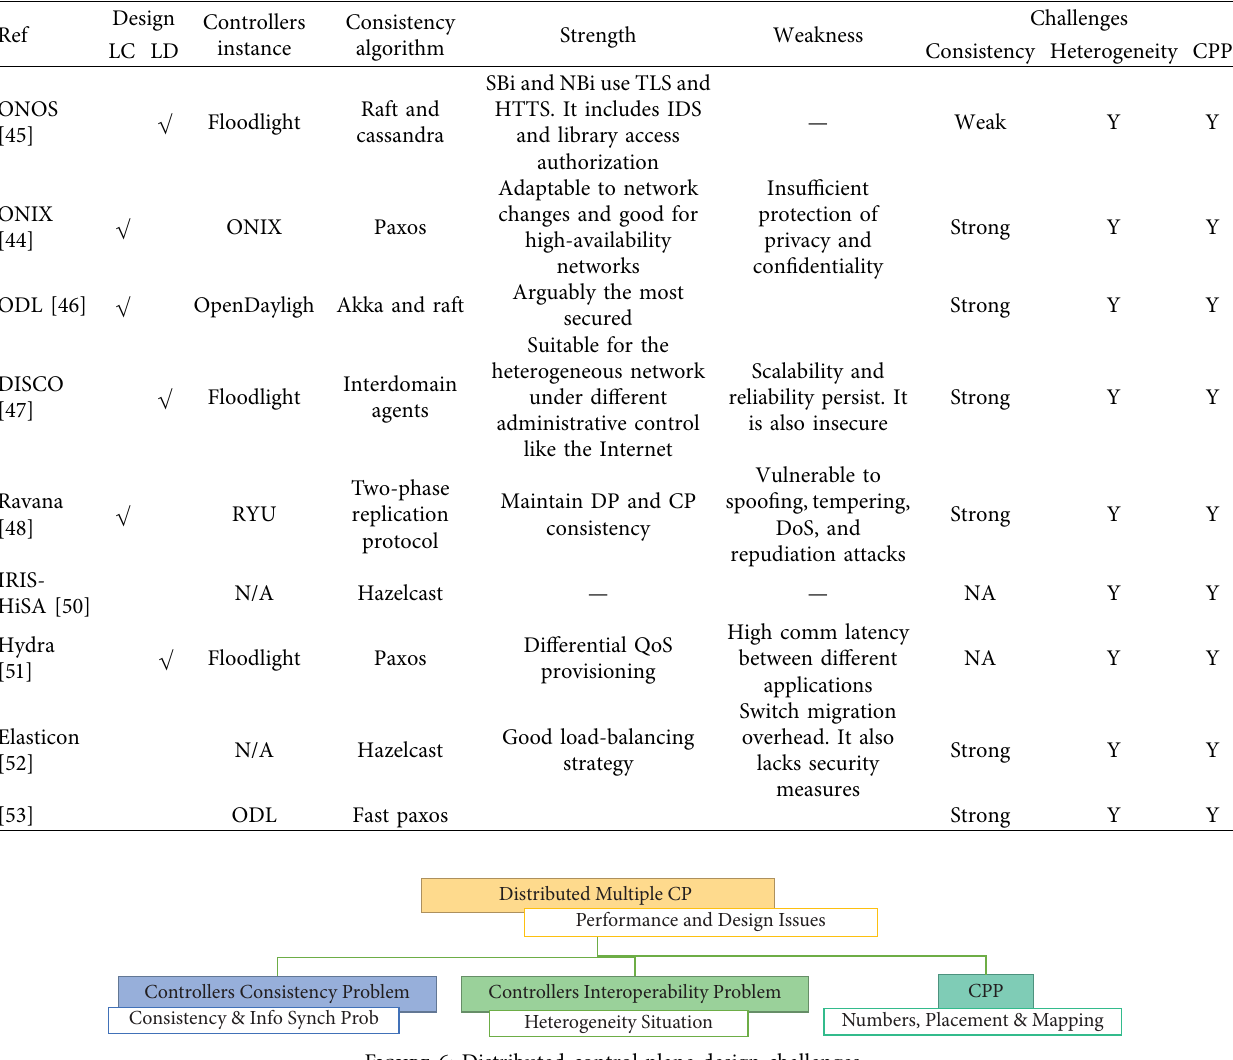
Table 3: Distributed control plane summary